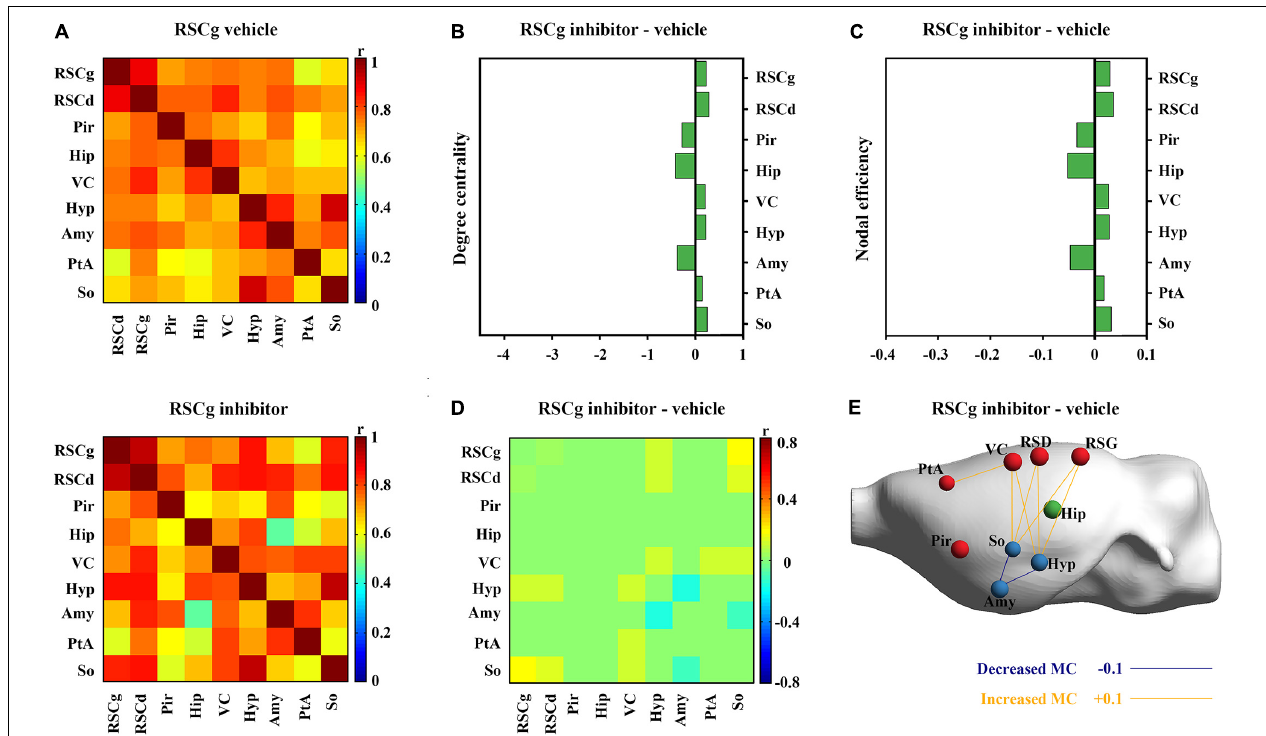
FIGURE 5 | Effects of suppressed RSCg on its core metabolic networks during CFC. (A) Core metabolic network of RSCg vehicle and inhibitor groups during CFC. (B) Degree centrality and (C) nodal efficiency of nodes in RSCg core network do not alter significantly in rats with suppressed RSCg. (D) 10,000 permutation tests reveal that the metabolic correlations of the hippocampus with other nodes also do not alter significantly in rats with suppressed RSCg. (E) The links that changed significantly in metabolic connectivity between nodes of rat brain with suppressed RSCd. MC, metabolic connectivity. RSCg vehicle group n = 35, RSCg inhibitor group n = 32. p < 0.05 was considered statistically